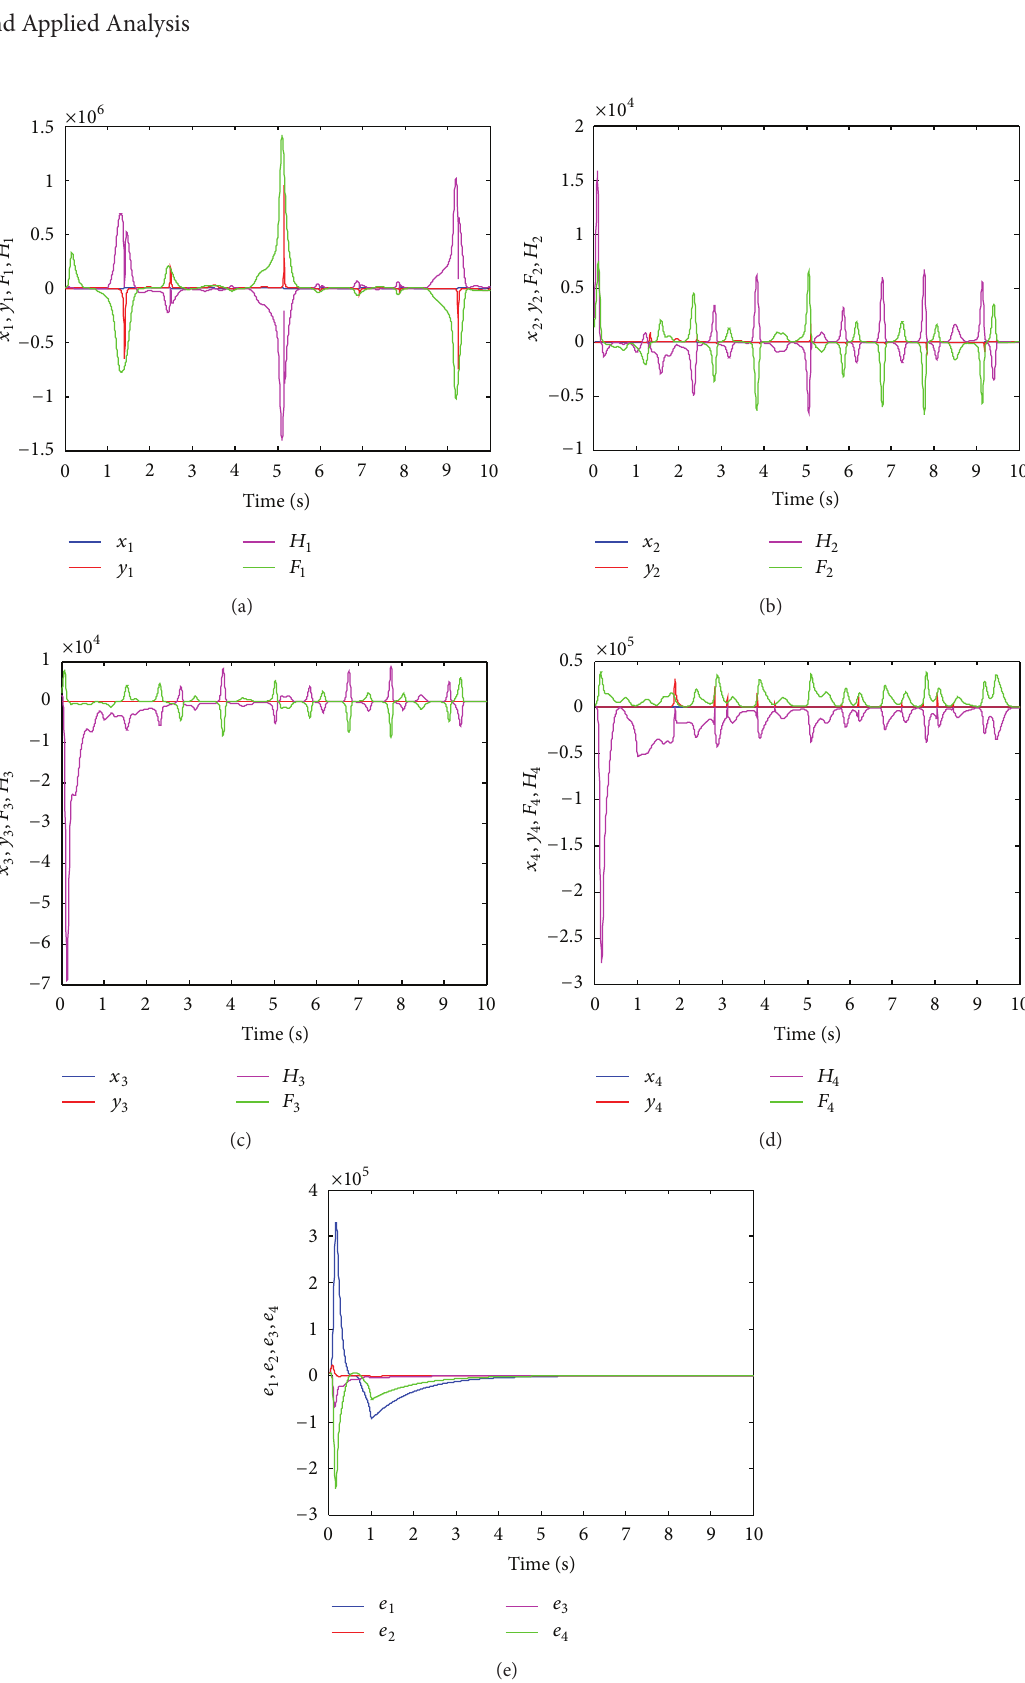
Figure 6: Time histories of states, state errors, 𝐹 1 , 𝐹 2 , 𝐹 3 , 𝐹 4 , 𝐻 1 , 𝐻 2 , 𝐻 3 , and 𝐻 4 for Case